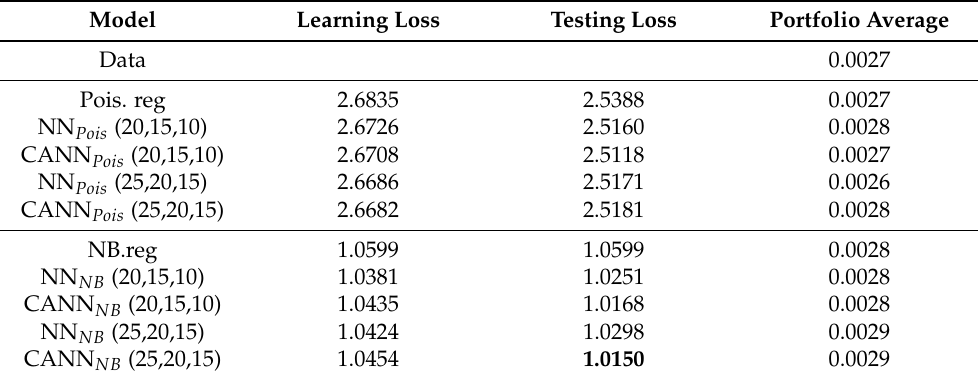
Table 8. Testing loss, learning loss, portfolio average of regression, and network-based models under the Poisson and negative binomial distributional assumptions.